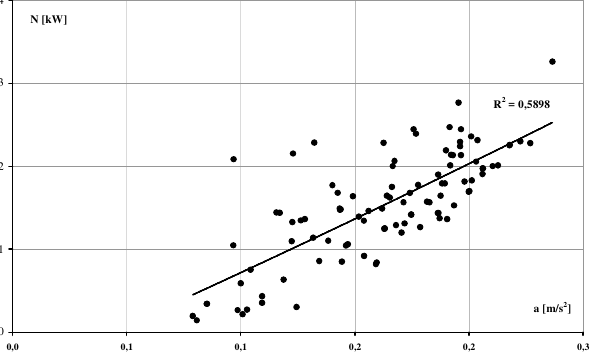
Fig. 8. Relationship between the average braking power and the average vehicle delay